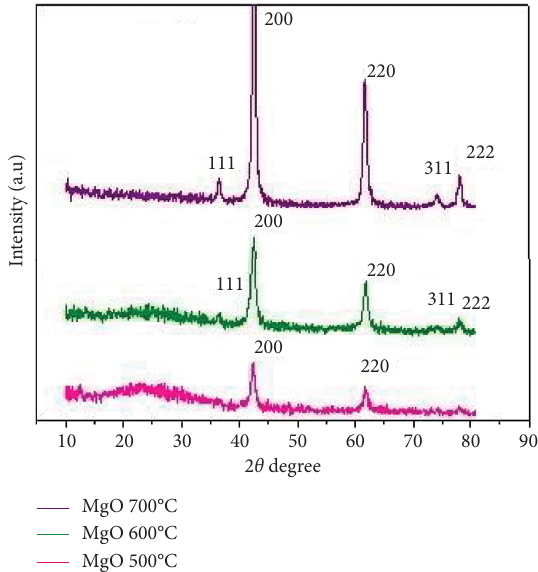
Figure 4: PXRD patterns of MgO nanoparticles at different calcination temperatures (500, 600, and 700 °